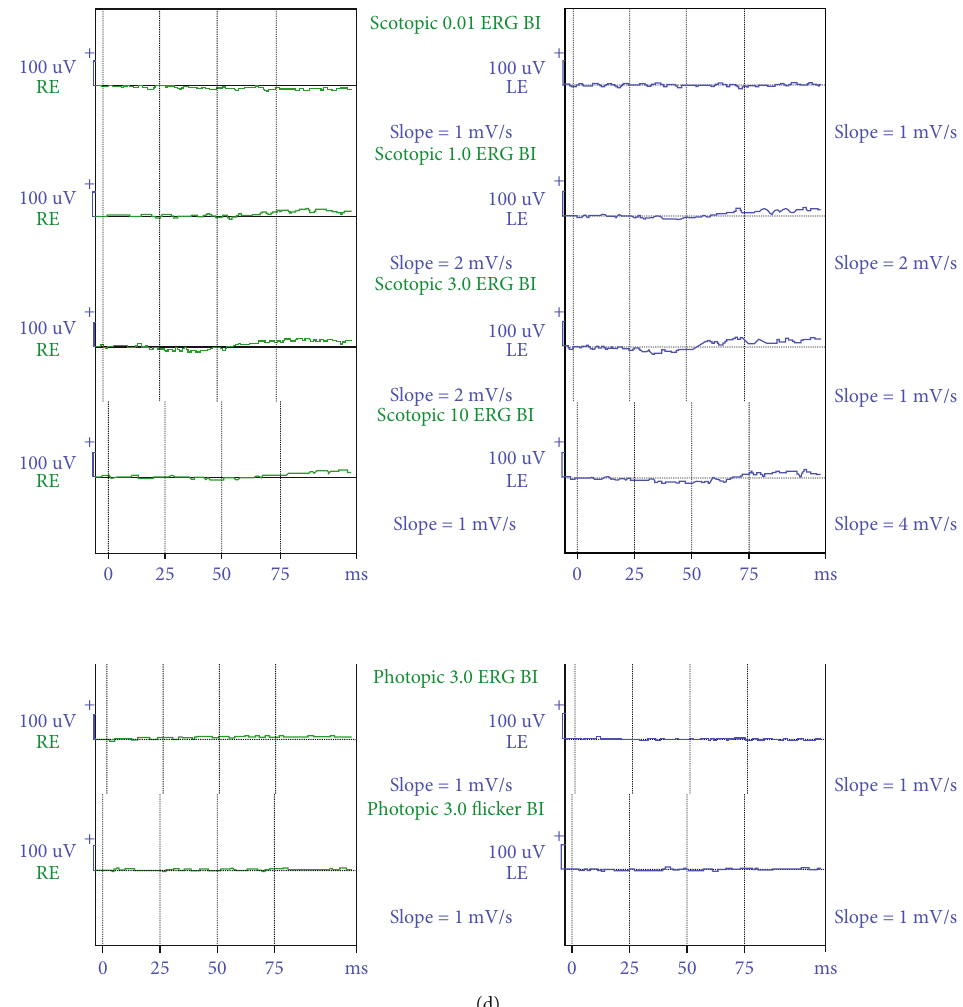
Figure 1: (a) The fundus photograph of both eyes shows a small area of myelinated axons on the inferior margin of the right optic nerve head and very mild peripapillary whitening and nerve fi ber layer swelling more prominent in the right eye. (b) Fundus auto fl uorescence images show a hypoauto fl uorescent area corresponding to the small area of myelinated axons on the inferior margin of the right optic nerve head and the normal appearance of the left eye. (c) Macular optical coherence tomography (OCT) revealed di ff use outer nuclear layer hyperre fl ectivity and indistinguishable external limiting membrane and ellipsoid. (d) Electroretinography displayed severely attenuated responses in both